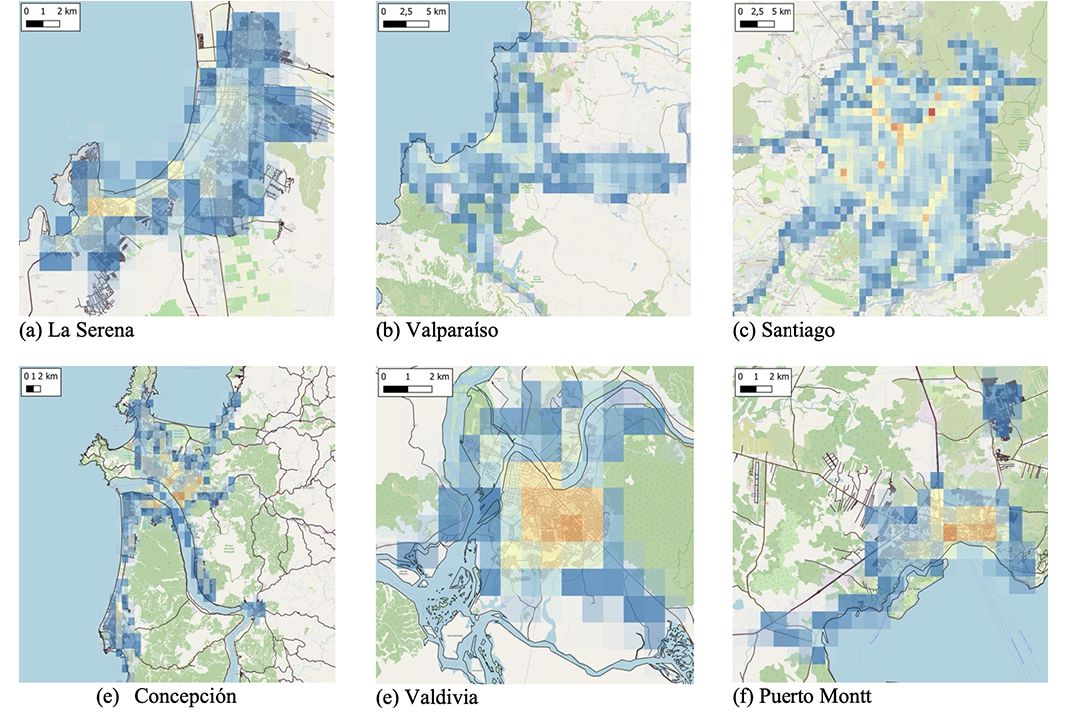
Figure 7. Spatial disaggregation of NO x exhaust emissions for six cities in Chile, 2020, as a fraction of Ggyr − 1 . The colour legend is the same as in Fig. 6.